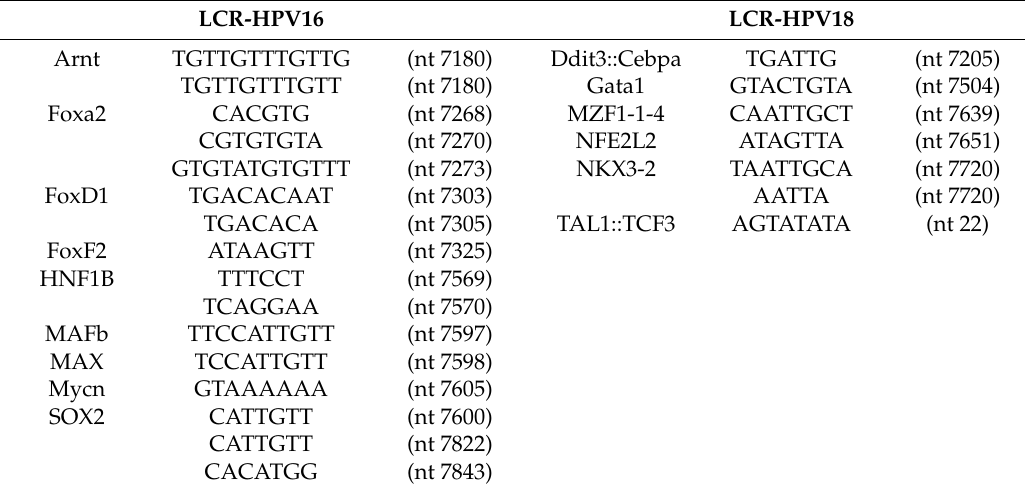
Table 1. In silico prediction of transcription factor binding sites exclusive for HPV16- or HPV18-LCR.